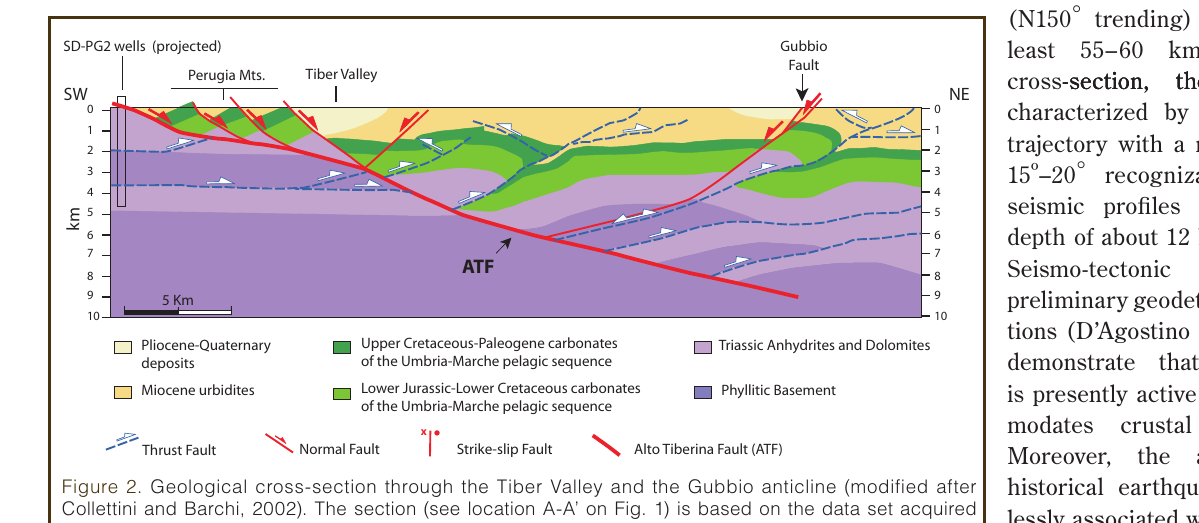
(Fig. 2�� has �een de�icted along a dee� seismic�� nearl��l��